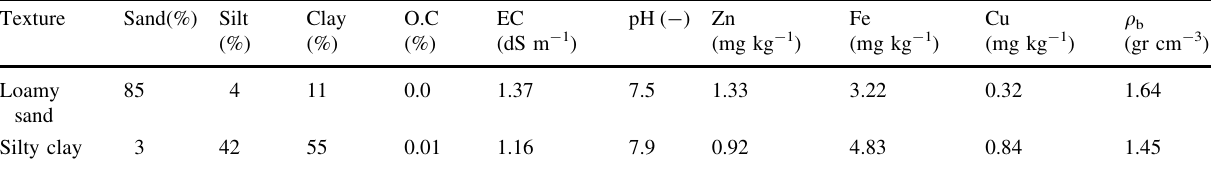
Table 2 Selected physical and chemical properties of the studied soils